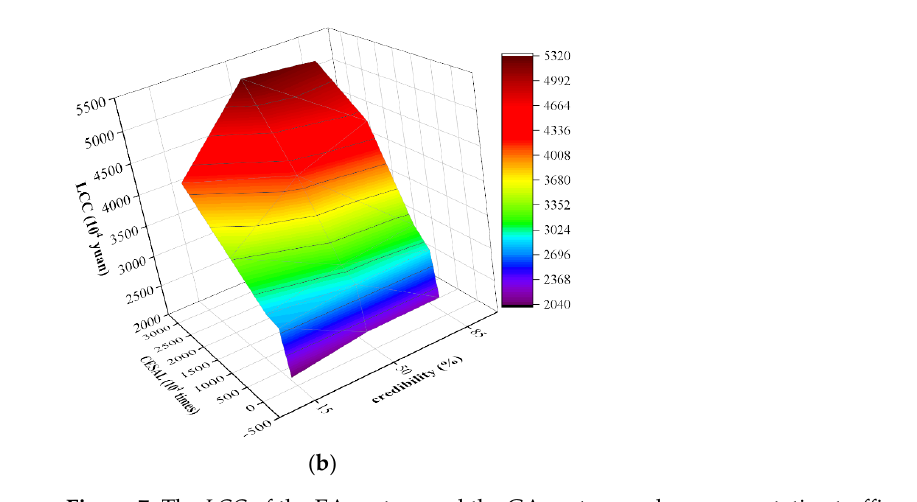
different credibility: ( a ) EA system; ( b ) GA system; CESAL = cumulative equivalent single axle